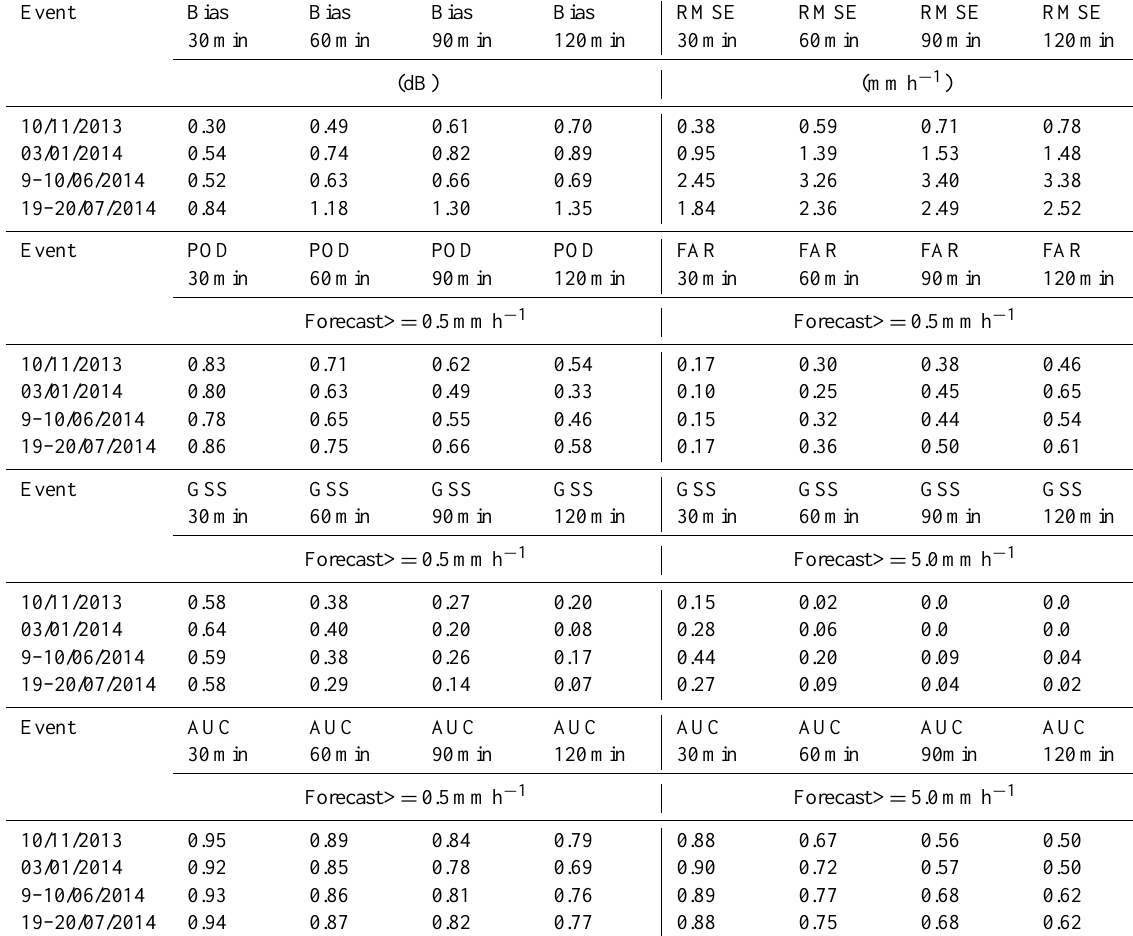
Table 2. Summary of the forecast verification scores of the next four 30min accumulation forecasts for the precipitation events in Ghent and Leuven. The lead time shown is the end of the 30min accumulation period (e.g., 60min is relative to the 30–60min accumulation). The bias values correspond to the standard deviation of the multiplicative bias, which is more interesting than its mean (often close to 0). Event